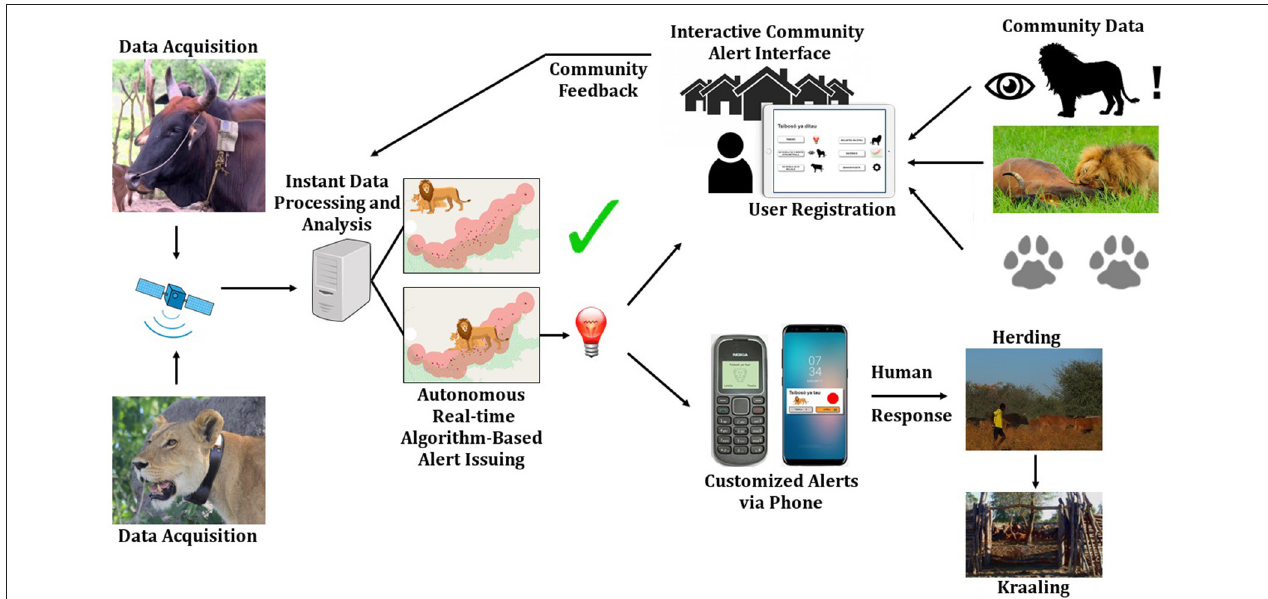
FIGURE 10 | Visualization of the autonomous, automated lion alert system with key features and functionalities.